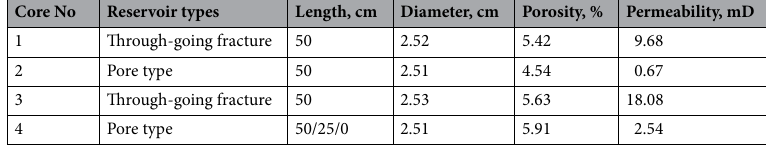
Table 1. Basic physical parameters of the four groups of cores used in the experiments.